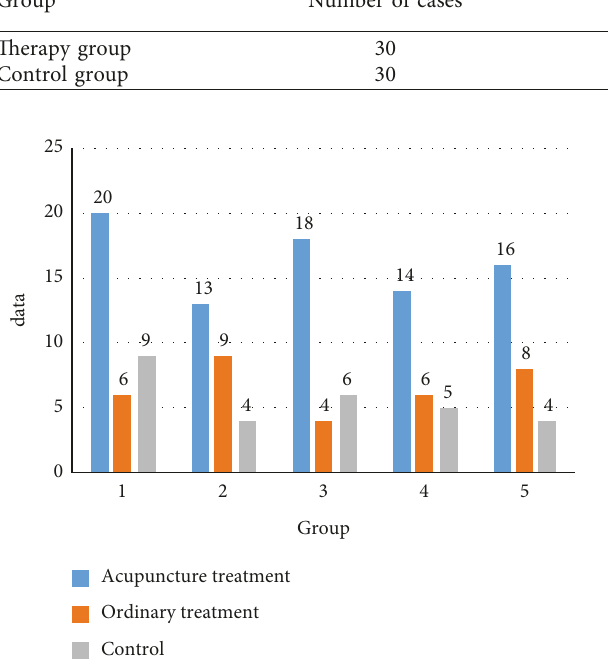
Table 1: Two groups before treatment in patients with H—B level of facial nerve. Group